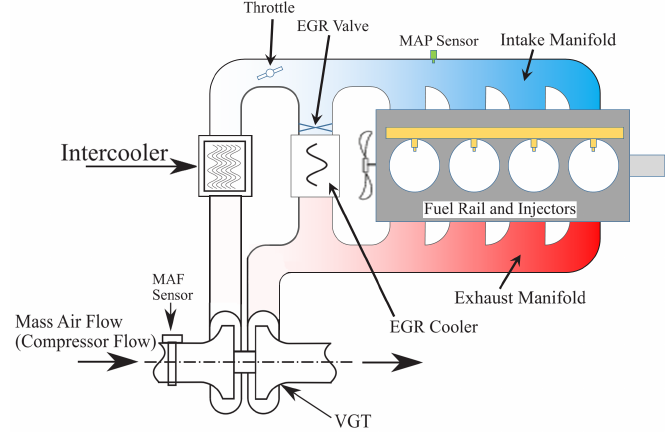
Figure 1. A diesel engine air-path